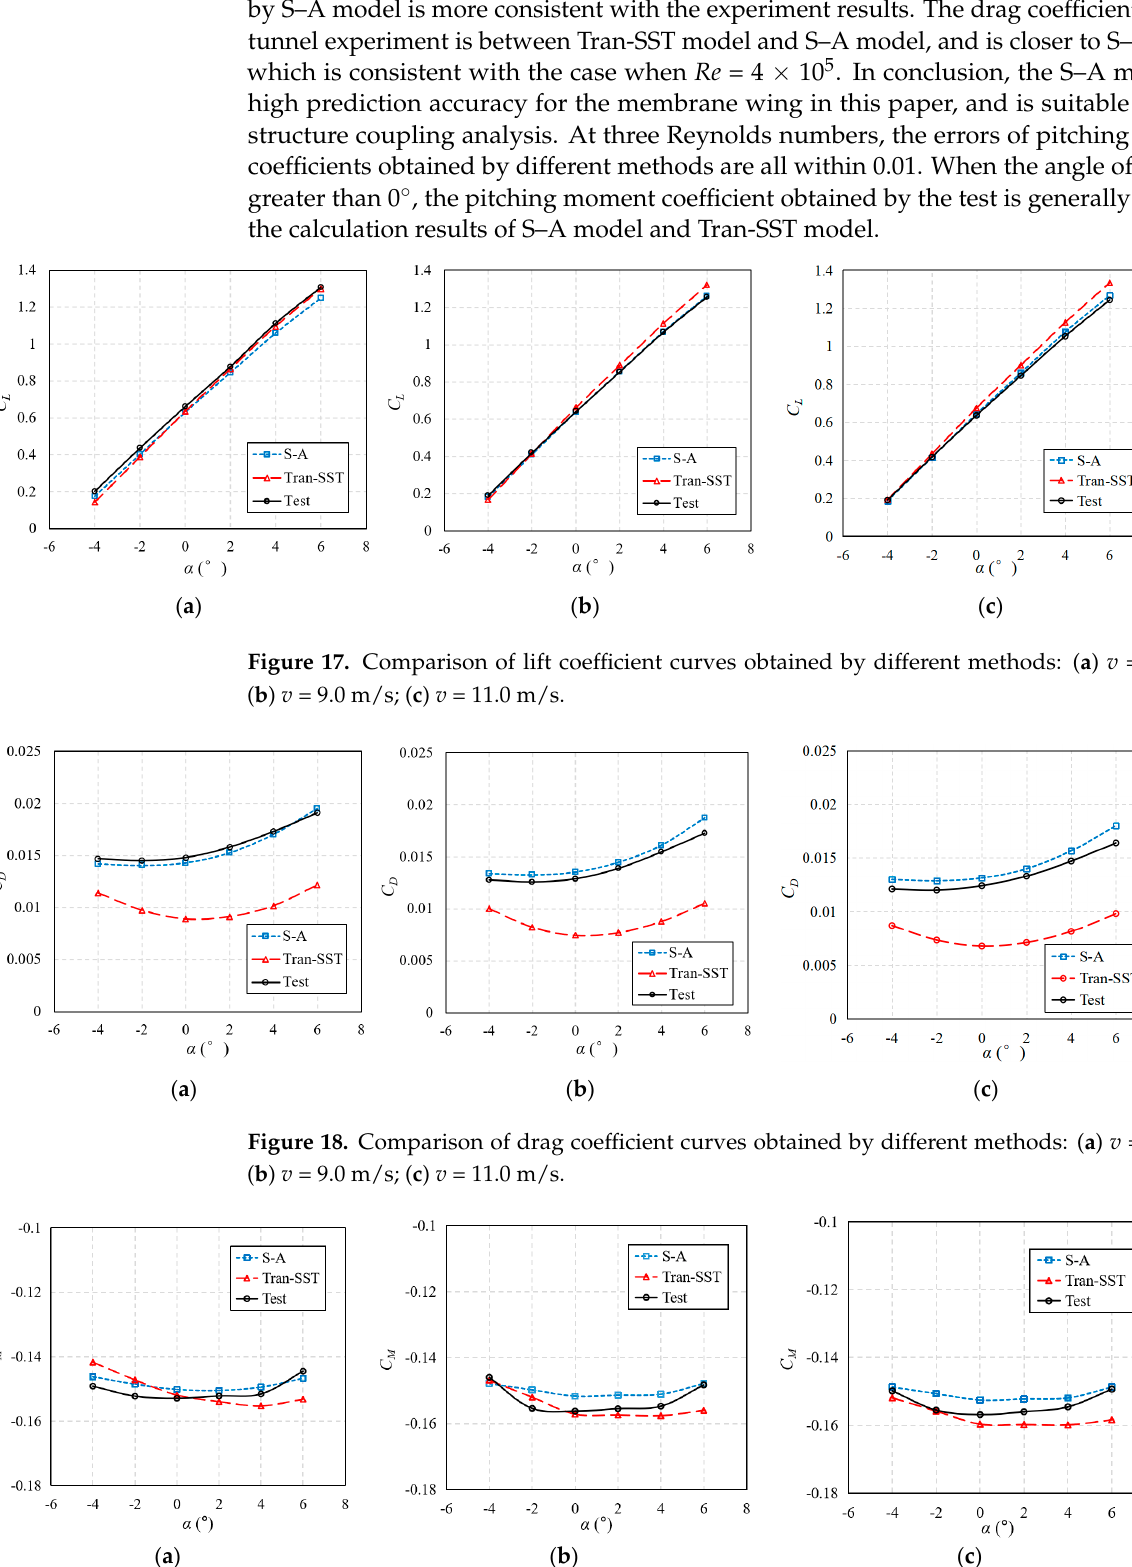
Figure 19. Comparison of pitching moment coefficient curves obtained by different methods: ( a ) v = 6.4 m/s; ( b ) v = 9.0 m/s; ( c ) v = 11.0 m/s.